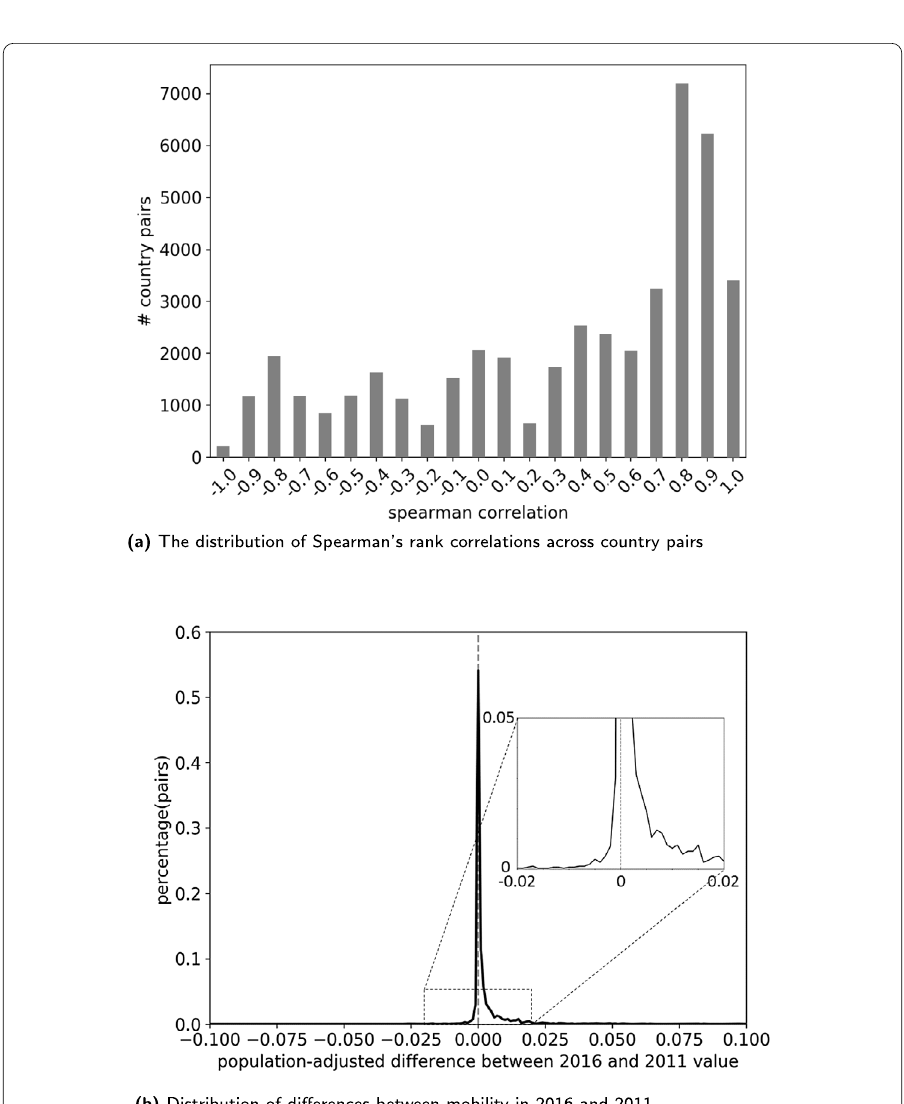
Figure 4 Assessing change in mobility trends over time. The Spearman’s rank correlations shown in subgraph ( a ) allow to infer whether a trend is monotonously increasing, decreasing, or stable/fluctuating. The cumulative distribution of the population-size-adjusted difference between the 2016 and the 2011 trend value shown in subgraph ( b ) illustrates the sizes of the changes. Negative values denote decreases, positive values denote increases. A value of 0.025 for instance denotes an increase in air passenger travels that corresponds to 2.5 percent of the sender-country population. A small number of extreme outliers